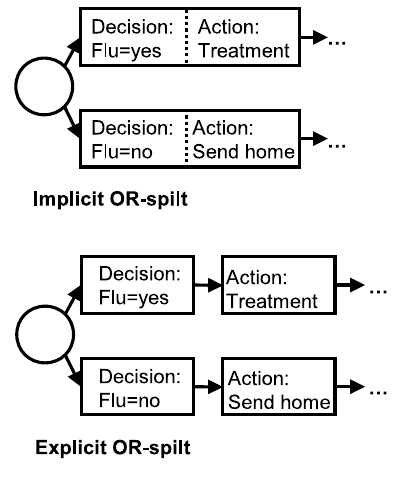
Fig. 2. Implicit and Explicit